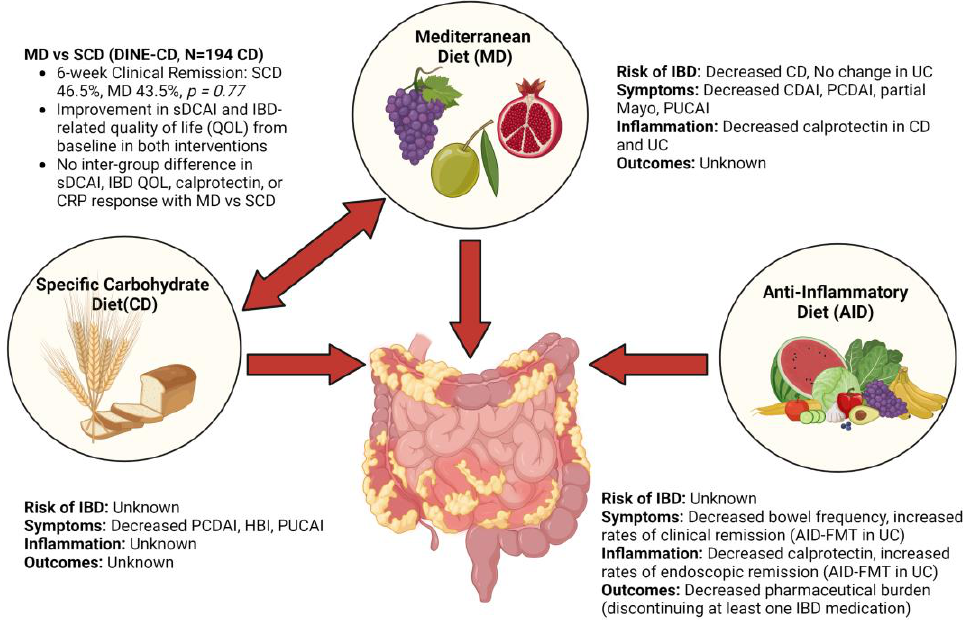
Figure 3. Specific Dietary Interventions in IBD: Mediterranean Diet (MD), Specific Carbohydrate Diet (SCD), and Anti-Inflammatory Diet (AID) .